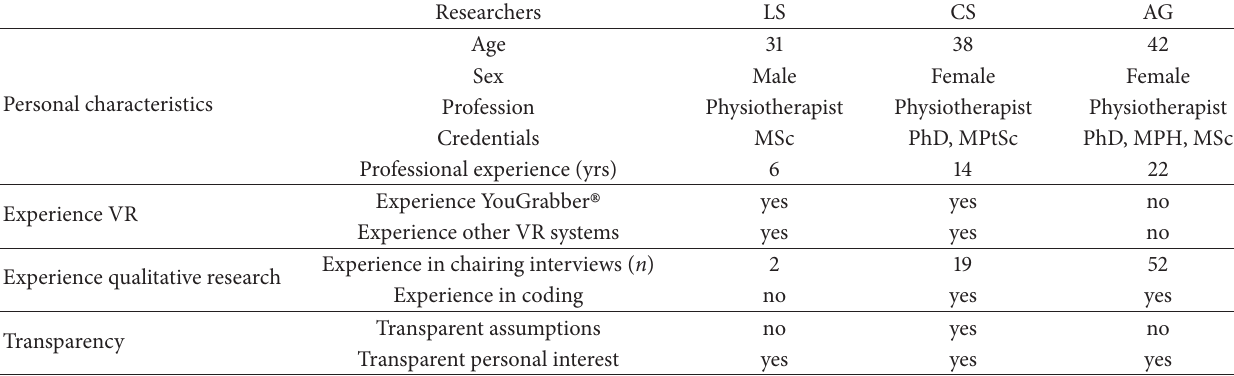
Table 1: Personal characteristics of all interviewees.